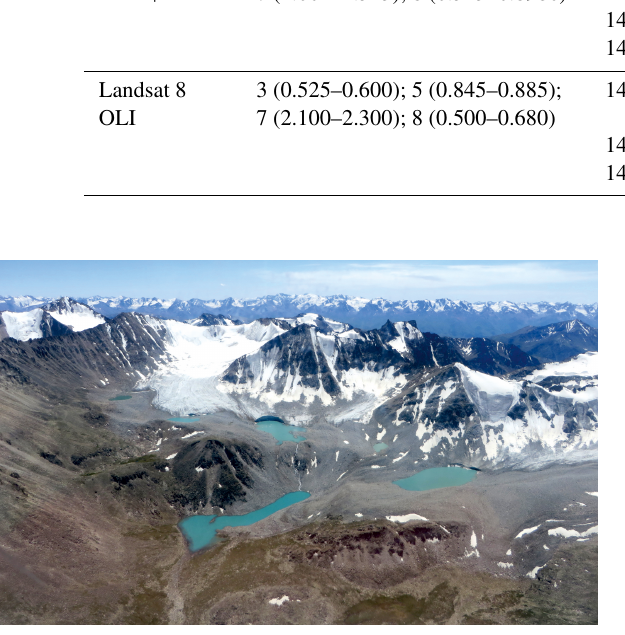
Figure 3. An example of the upper section of a cascade (vertical sequence) of lakes in the Aksu River basin (an oblique aerial photo- graph by M. Kasenov; July 2014). Figure 9a shows a Landsat scene depicting the